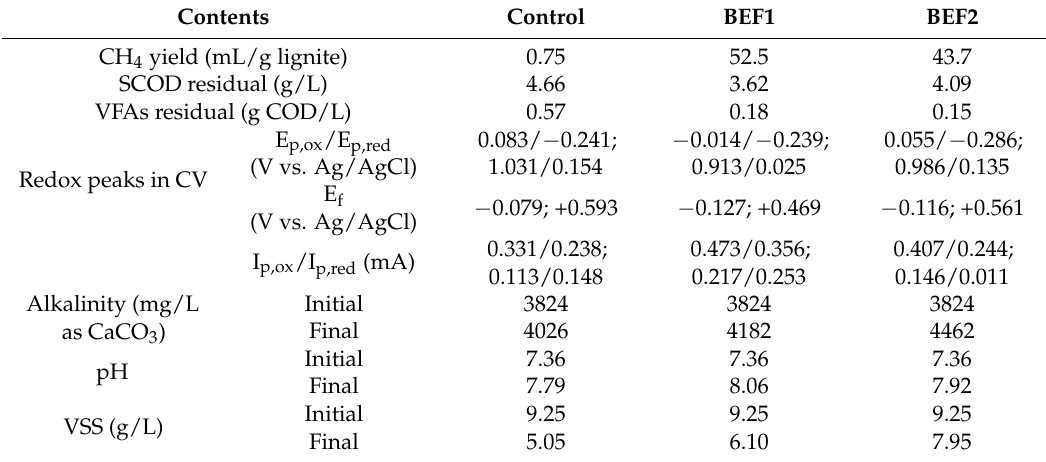
Table 1. Summary of biogenic conversion of coal to methane in bioelectrochemical anaerobic reactor.